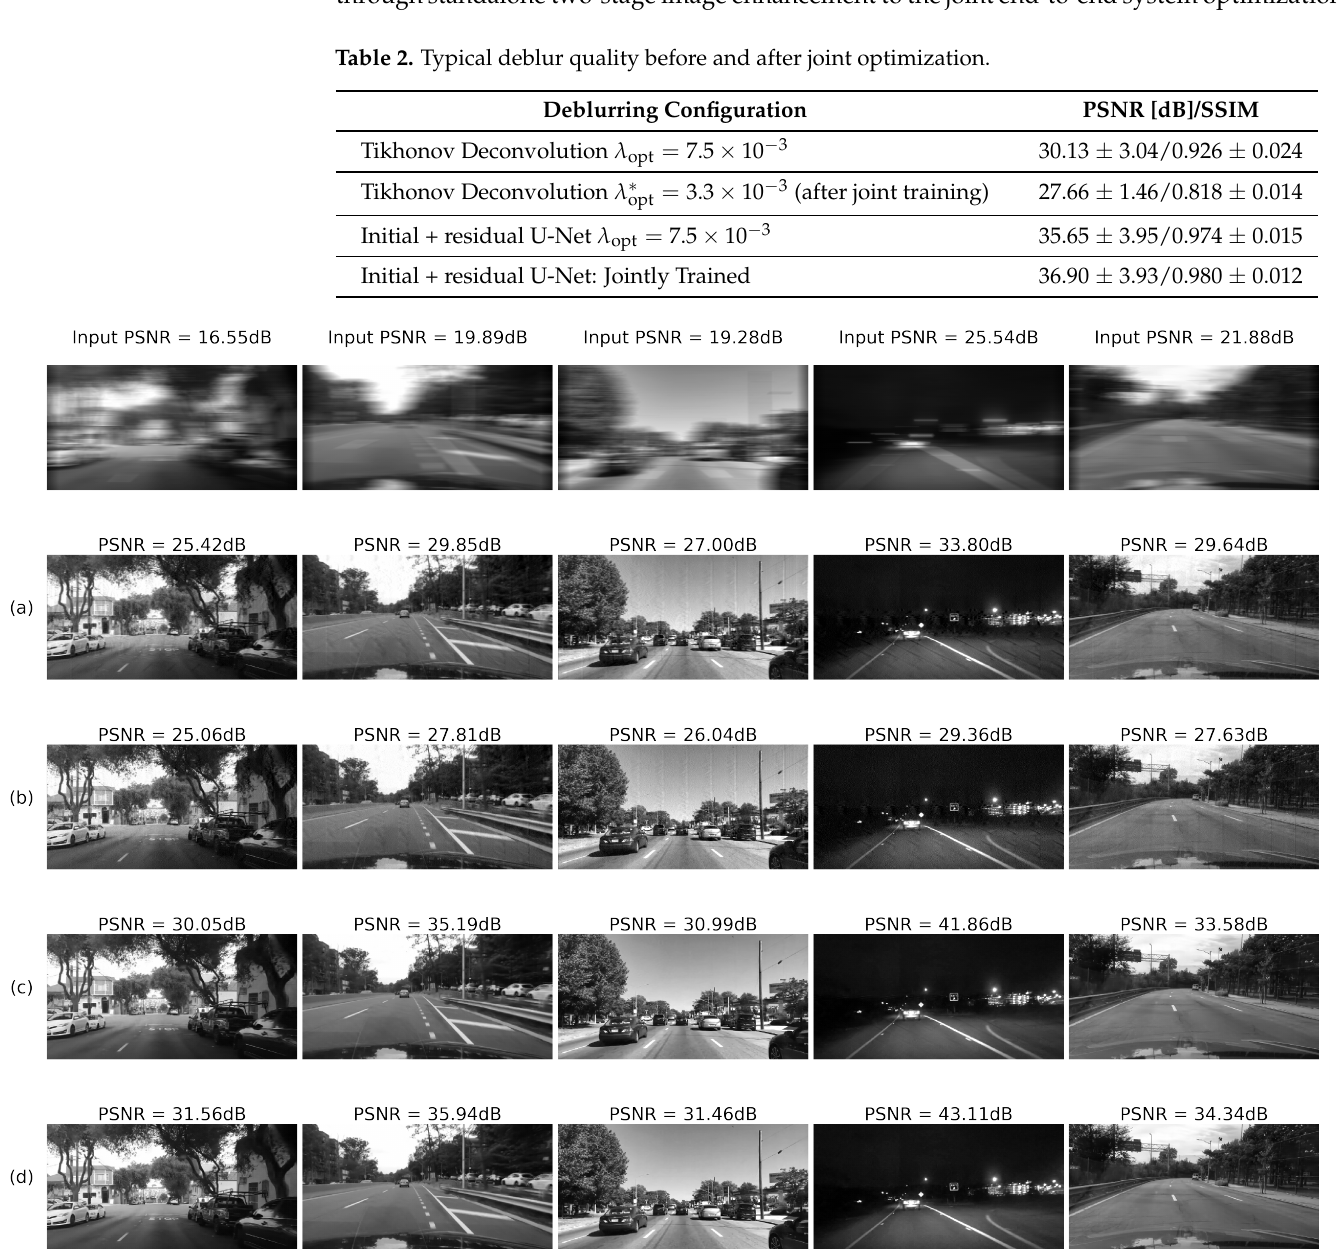
Figure 10. Effect of joint training for a set of images: ( a ) Deconvolved image with λ = λ opt ; ( b ) Decon- volved image after joint training; ( c ) Two-step deblurring ( d ) Two-step deblurring after joint